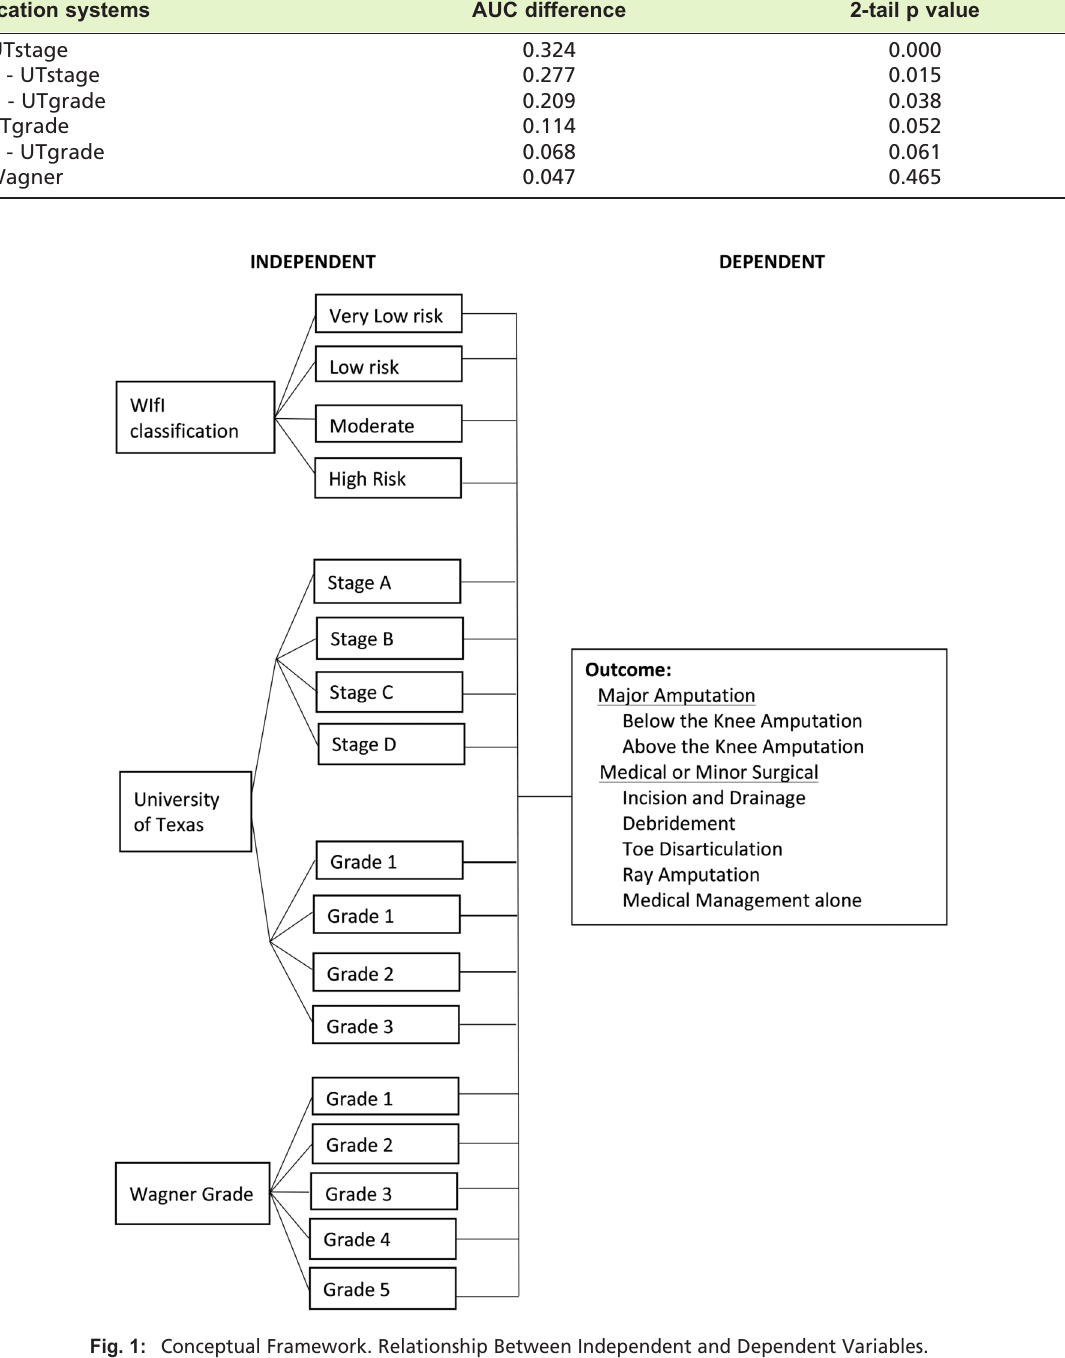
Paired analysis of Area Under the Receiver Operating Characteristic Curve (AUC) of the classification systems Table IV: Classification systems